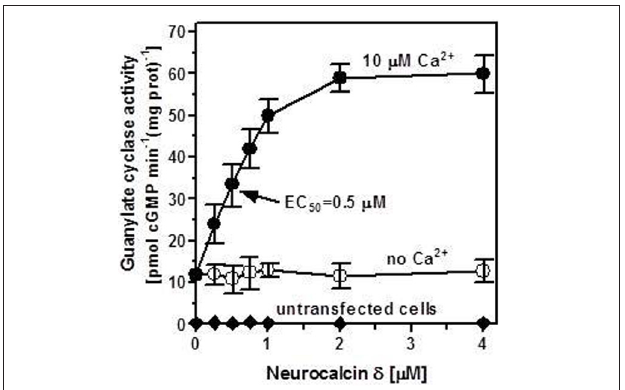
FIGURE 1 | Ca 2 + -bound neurocalcin δ stimulates ANF-RGC activity. COS cells were transfected with ANF-RGC cDNA and their membrane fraction was analyzed for neurocalcin δ -dependent cyclase activity in the absence (open circles) and presence of 10 μ M Ca 2 + (closed circles). COS cells transfected with an empty vector were analyzed identically (closed diamonds). The extracellular hormone ligand of ANF-RGC, the atrial natriuretic factor (ANF) was absent from the reaction mixture. The experiment was done in triplicate and repeated four times. The results shown are average ± SD from these experiments. The EC 50 value was determined graphically. Neurocalcin δ used was myristoylated. The myristoylated form of neurocalcin δ was expressed and purified as described in Krishnan et al.